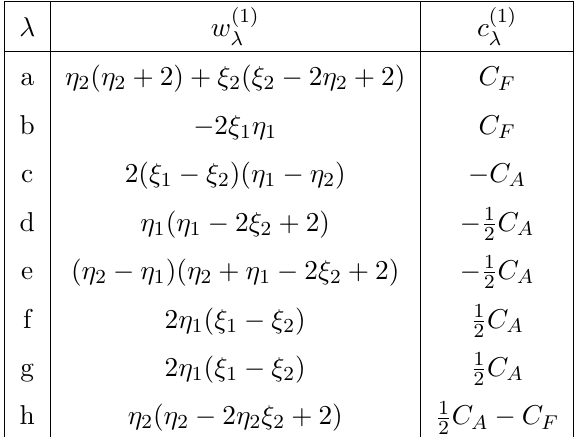
Table 6 . The weights w (1) and the color factors c (1) for the diagrams in (cid:12)gure 8. The contributions (cid:21) (cid:21) of the diagrams with the opposite direction of the closed quark line are included.